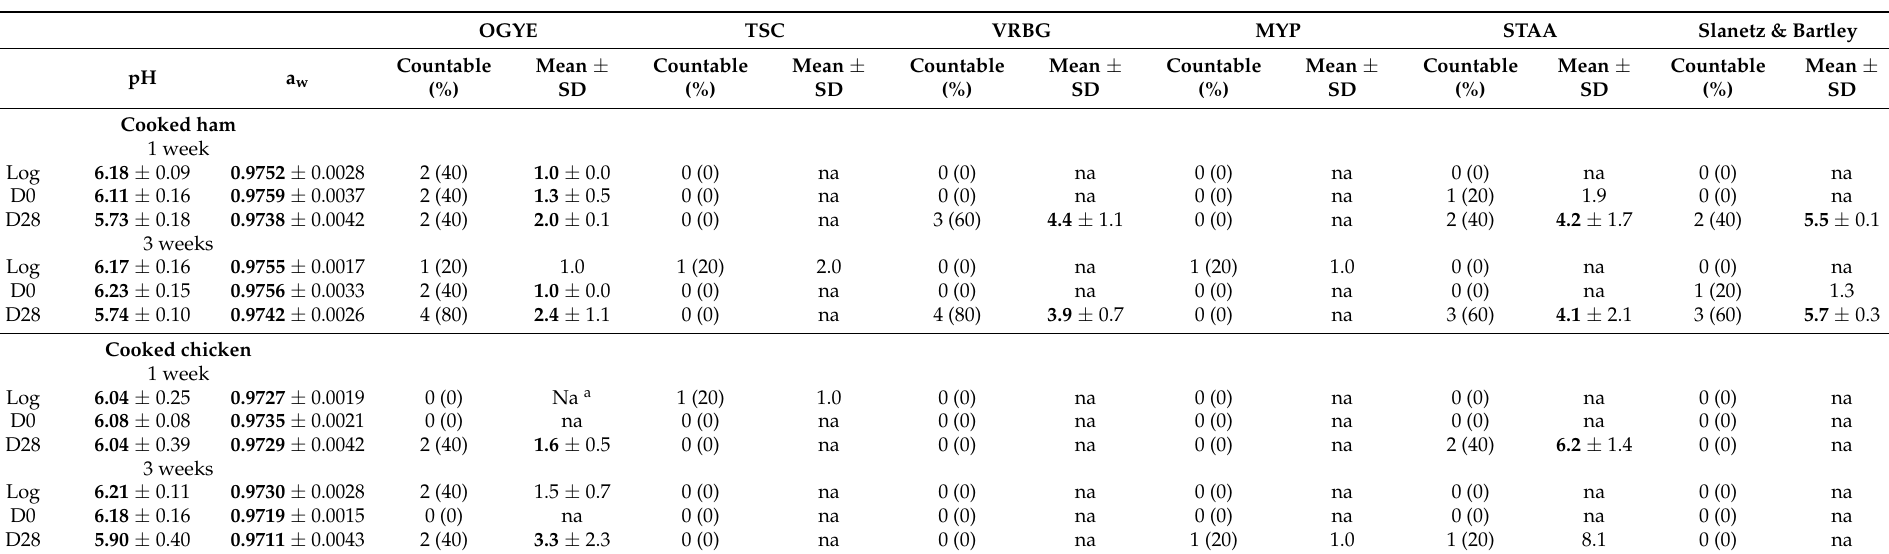
Table 1. Values at three different production stages [unsliced log, after slicing (D0) and at end of the shelf-life period (D28)] for yeast and fungi (OGYE), sulphite-reducing clostridia (TSC), Enterobacterales (VRBG), presumptive Bacillus cereus (MYP), Brochothrix thermosphacta (STAA) and Enterococcus (Slanetz & Bartley), as well as the corresponding average (in bold) and standard deviation for pH and a w values. For microbial counts, mean (in bold) and standard deviation log (CFU/g) values are given when there is more than one countable sample. In other instances, the log CFU/g value is given, in case of only one sample being countable, or the value is assigned as not detectable, when no samples were countable. The percentage of countable samples for each parameter was calculated based on the total number of samples taken at this specific production